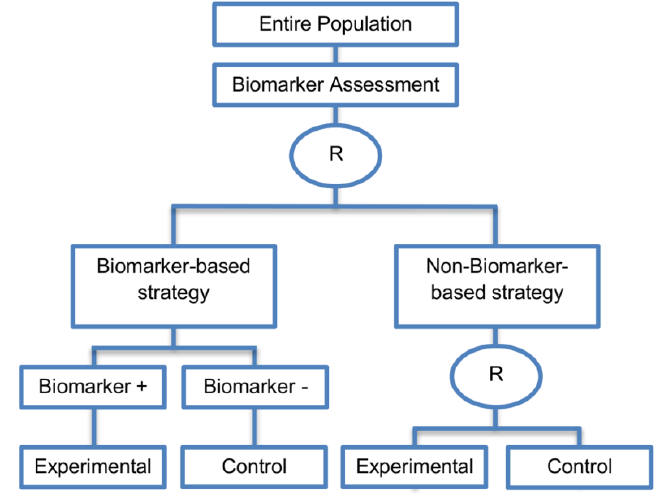
Figure 14. Biomarker-strategy design with treatment randomization in the control arm. “R” refers to randomization of patients. randomization of